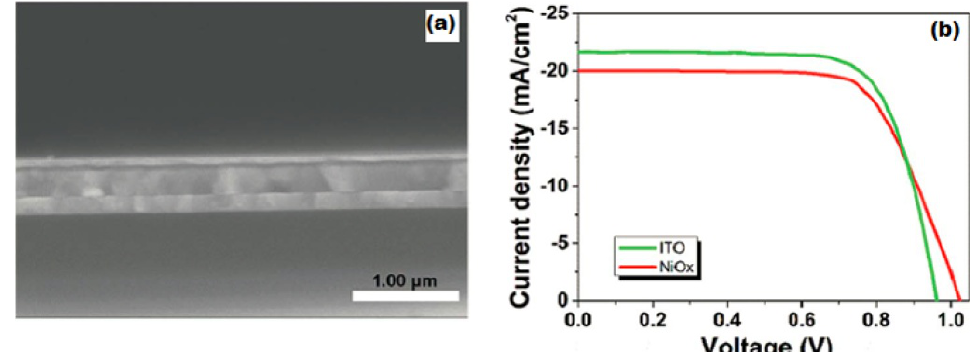
Fig. 8. Structure (ITO/CH NH PbI /C /BCP/Ag) and performance of HTL free device: (a) cross sectional 3 3 3 60 SEM image of device and (b) J-V curve of with and without hole transport layer, reprinted with permission from Y. Li, S. Ye, W. Sun, W. Yan, Y. Li, Z. Bian, Z. Liu, S. Wang and C. Huang // J. Mater. Chem. A 3 (2015) 18389. © 2015 Royal Society of Chemistry. Efficiencies of the device were 14.2% and 16% with and without HTM respectively.